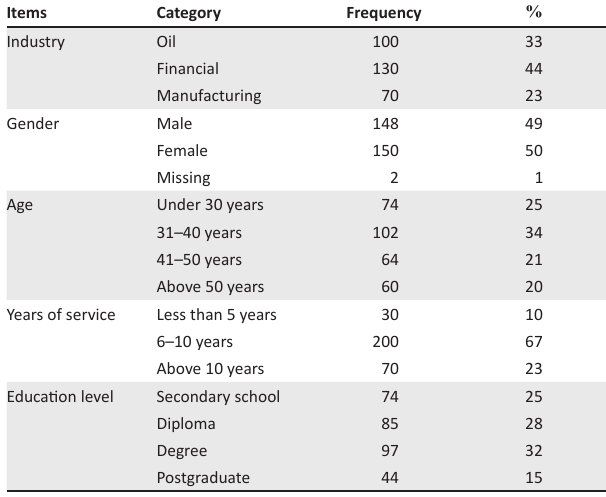
TABLE 1: Characteristics of the participants.